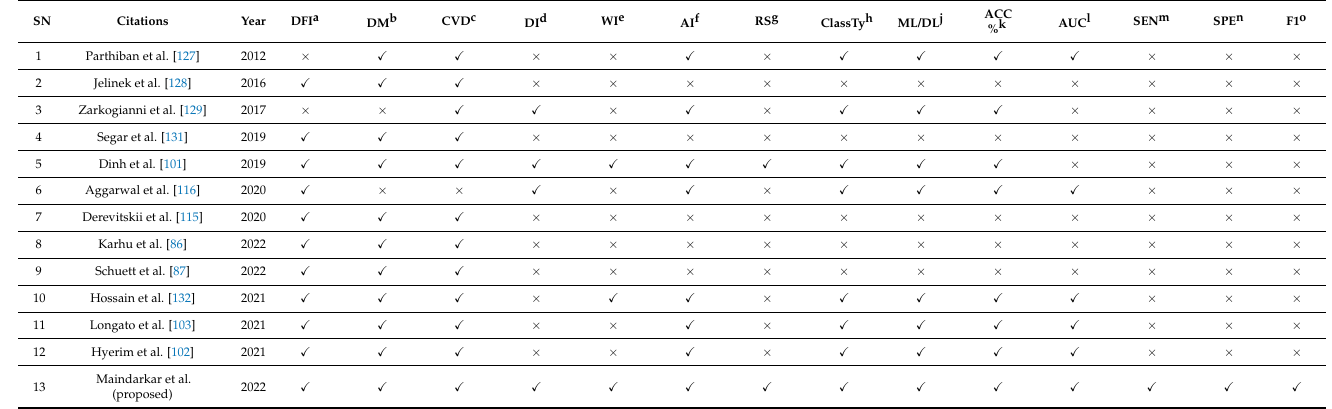
DFI a : Diabetic foot Infection, DM b : Diabetic Melliuties, CVD c : Cardiovascular diseases, WI d : Wound Imaging, CI e : Carotid Imaging AI f : Artificial Intelligence, RS g : Risk Stratification, ClassTY h : Type of Classifier, ACC k : Accuracy, AUC l : Area under curve, SEN m : Sensitivity, SPE n :